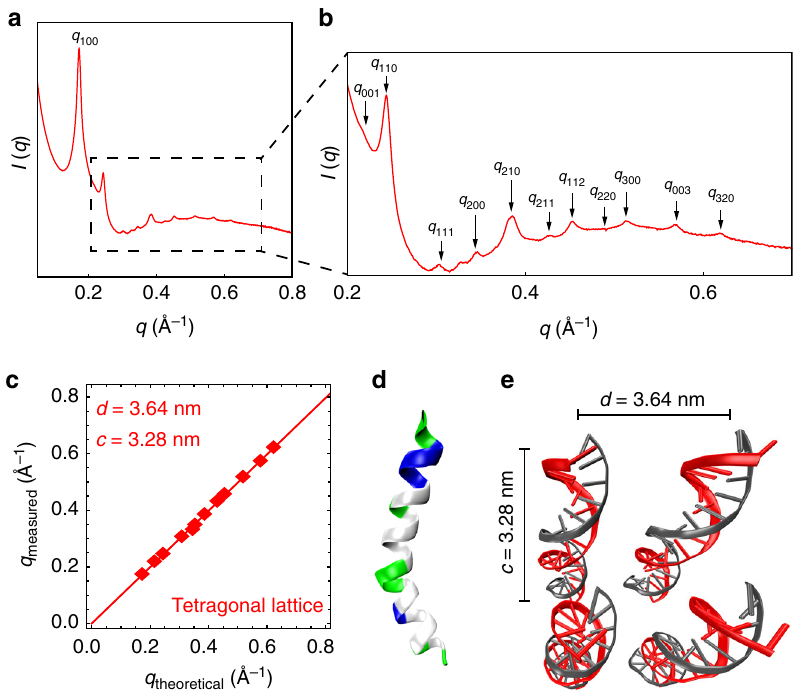
Fig. 1 Small-angle X-ray scattering (SAXS) structure of melittin-double-stranded DNA (dsDNA) complexes. a Representative SAXS data of an isoelectric melittin-dsDNA complex with the fi rst Bragg peak q 100 indicated. b The magni fi ed data region shows details of diffraction features q hkl , which index well to a three-dimensional tetragonal lattice. c To obtain the lattice parameters, we fi t the measured Bragg peak positions to predicted re fl ections using multiple linear regression. The lattice parameters of the melittin-dsDNA complex are d = 3.64 nm and c = 3.28 nm ( R 2 = 0.999). d Structure of the melittin monomer (PDB: 2MLT_A 57 ). Cationic residues are colored blue, hydrophobic residues are colored white, and polar uncharged residues are colored green. e Schematic of parallel dsDNA rods within the melittin-dsDNA tetragonal lattice labeled with lattice parameters obtained from SAXS. The average domain size of the melittin-dsDNA lattice is L ~ 62.4